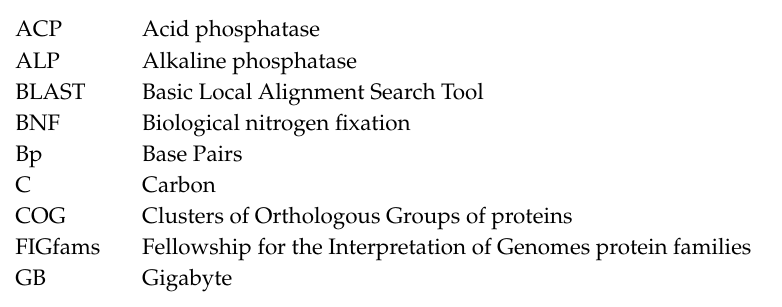
Figure S1: Relative abundance of top 50 common bacterial taxa within microbial communities identified from lentil cultivars Moitree (M) and Farmer-2 (F) using R package P heatmap, Figure S2: Principal component analysis (PCA) based on shared common taxa profiles at phylum reads variance from lentil cultivars Moitree (M) and Farmer-2 (F), Figure S3: The Krona graph showing the relative abundance of annotated taxa in lentil cultivar Moitree, Figure S4: The Krona graph showing the relative abundance of annotated taxa in lentil cultivar Farmer-2, Table S1: Summery table representing comparative analysis between the samples of two lentil cultivars, Table S2: Summery of predicted genes from two lentil cultivars related with nitrogen (N) cycling under rice-fallow ecology along with t-Test: Paired Two Sample for Means, Table S3: Summery of predicted genes from two lentil cultivars related with phosphorus (P) cycling under rice-fallow ecology along with t-Test: Paired Two Sample for